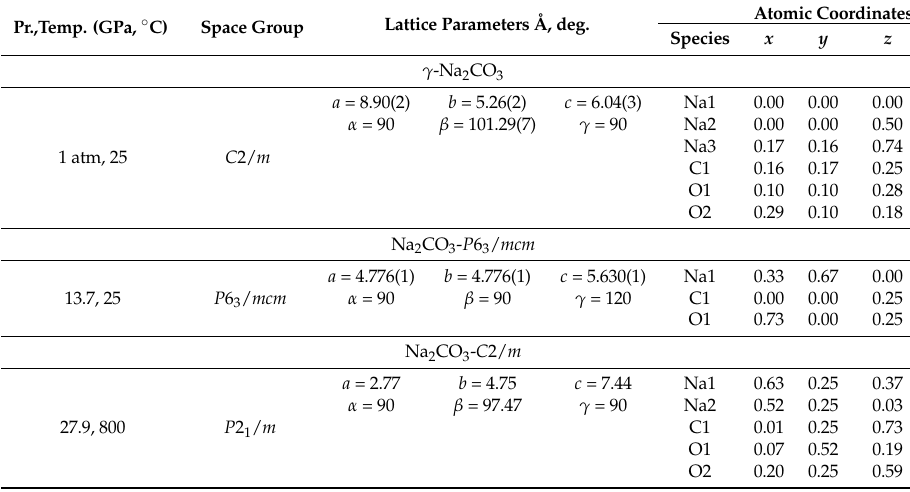
Table 1. Structural data for high-pressure phases of Na 2 CO 3 used for indexing and refinements. Cell parameters of P 6 3 / mcm - and γ phases according to Pawley refinement, other structural data according to DFT calculations.